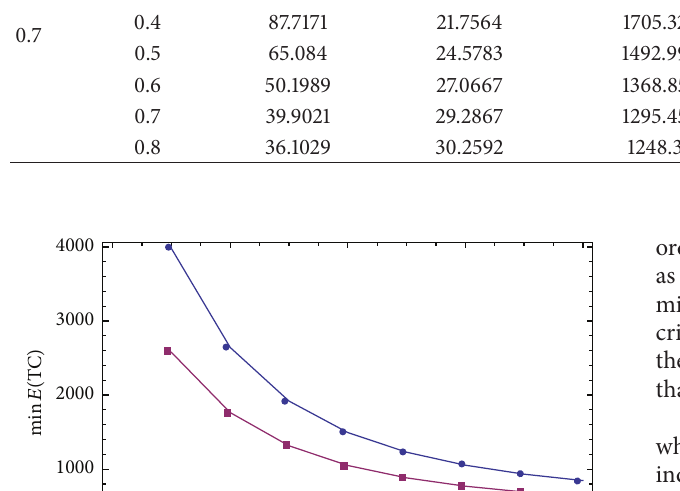
order quantity 𝑄